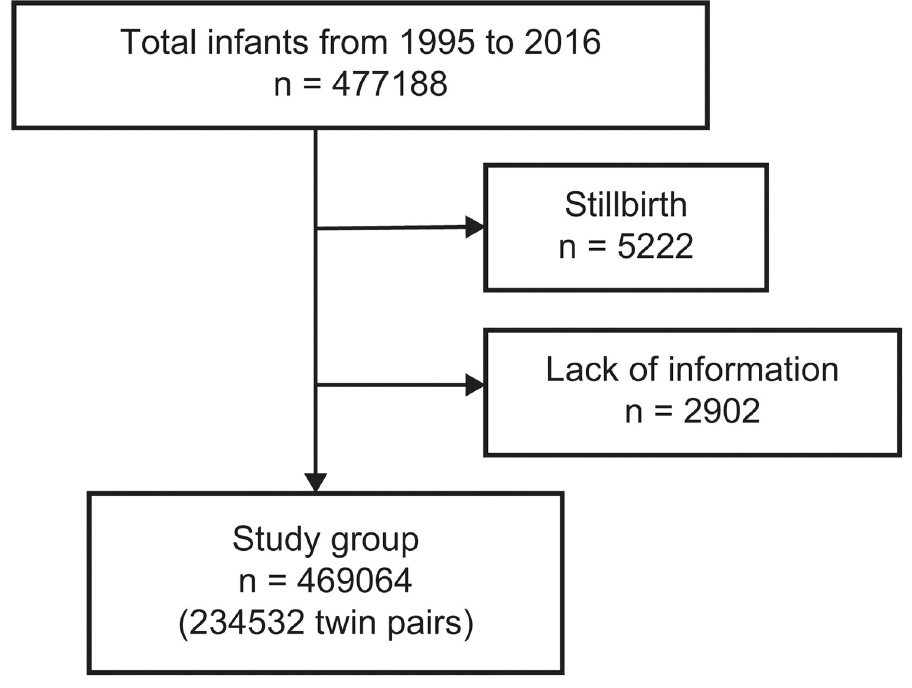
Fig 1. Flow chart for selecting